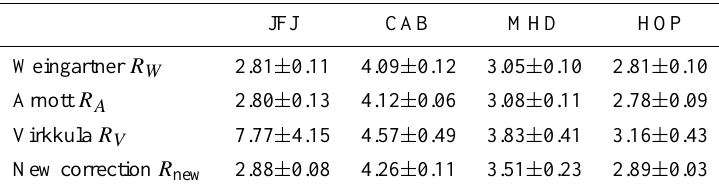
Table 4. Mean C ref constants with standard deviations for all four filter-loading corrections for JFJ, CAB, MHD and HOP stations. The correlation with the MAAP was done with λ =660nm at JFJ and CAB.